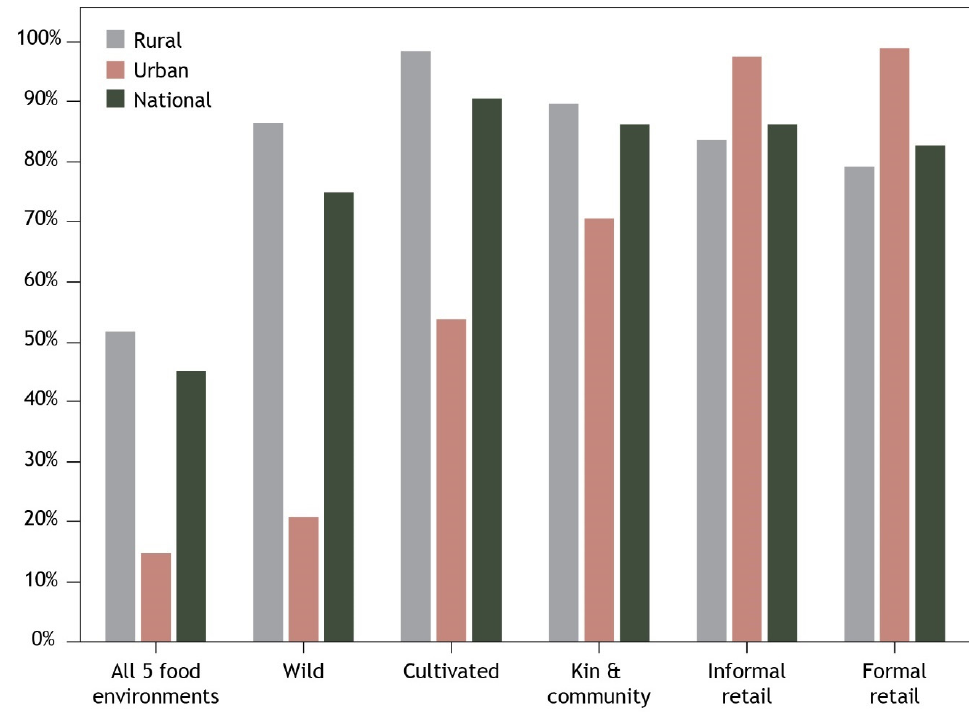
Figure 2. Proportion of households accessing different food environments in Solomon Islands, nationally and in urban and rural areas. Table 2. Effect of reliance on different FEs (independent variables) on two measures of diet quality (fruit and vegetable acquisition, and ultra-processed food acquisition).